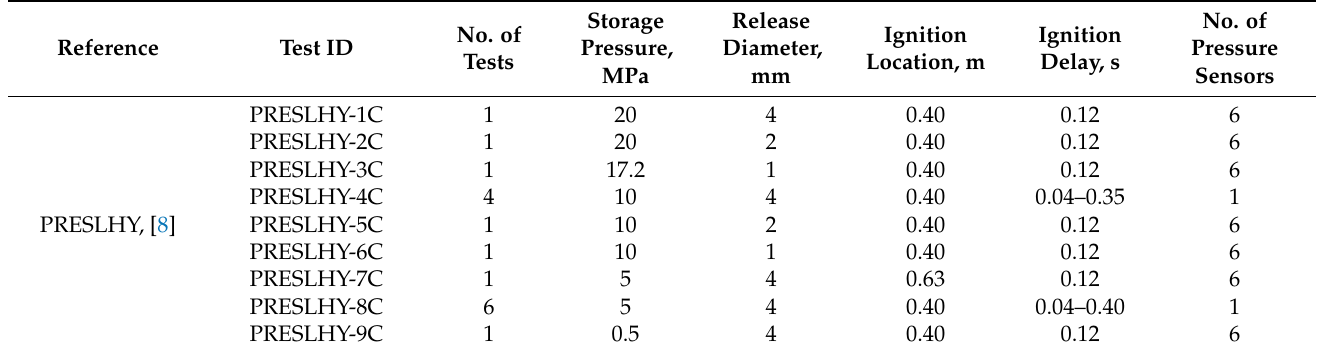
Table 2. Experimental conditions of the validation tests at a cryogenic hydrogen storage temperature of 80